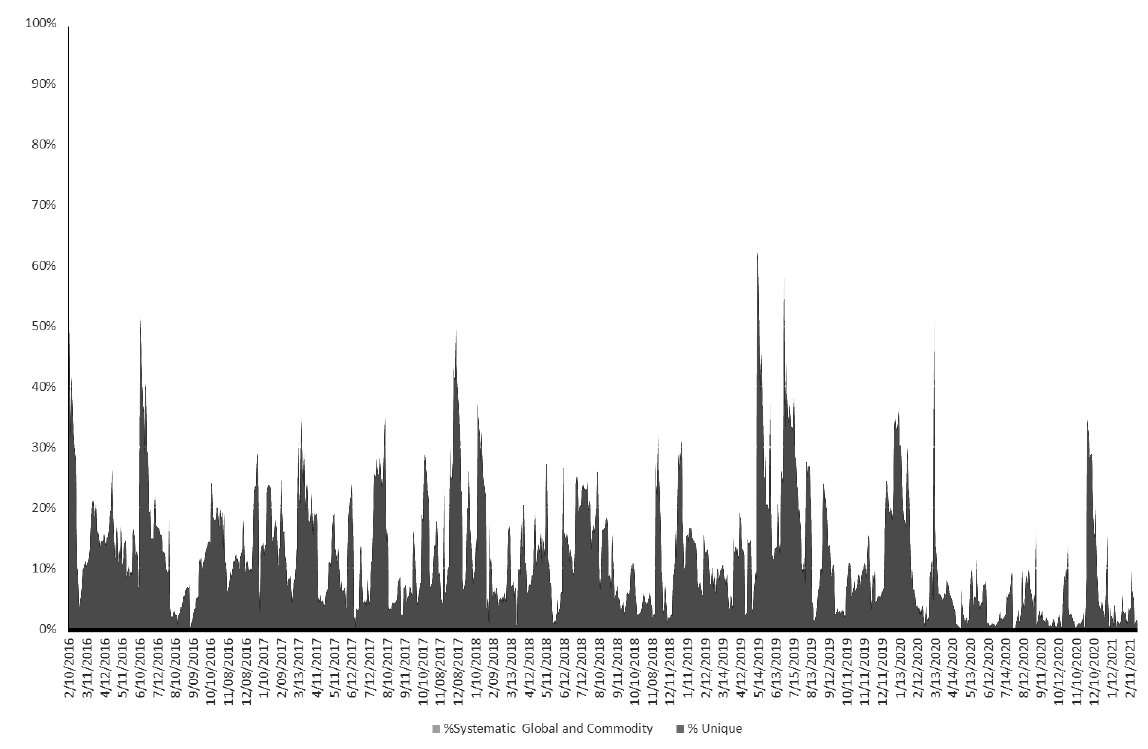
Figure 3. Conditional variance decomposition: Bitcoin returns from February 10, 2016 to March 2,